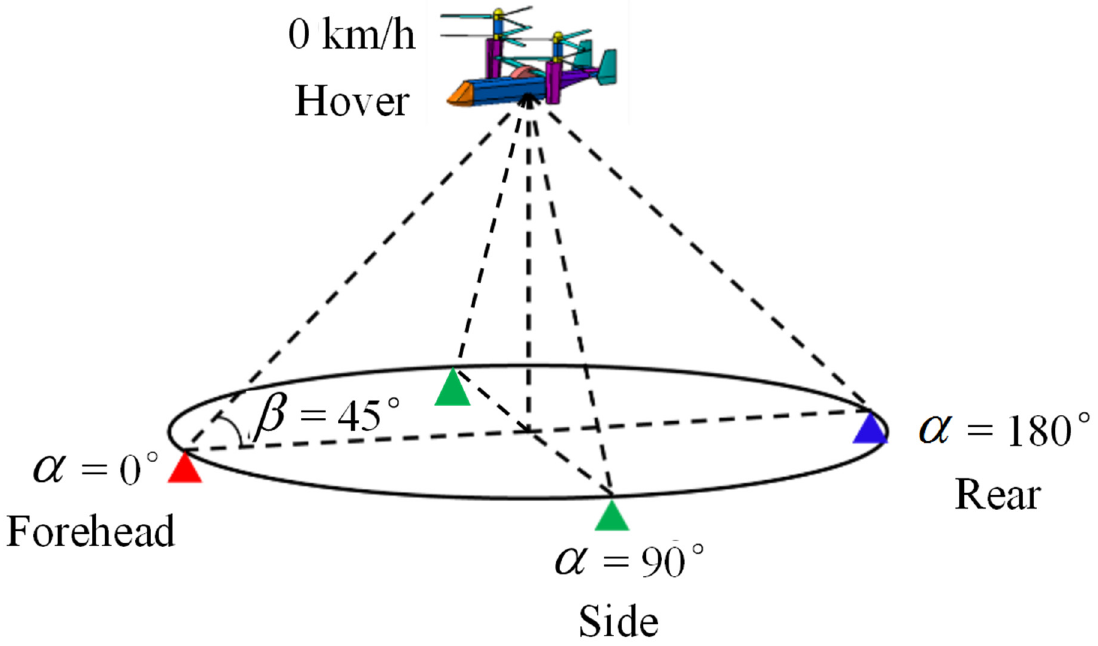
Figure 8. Schematic diagram of simulation in helicopter mode.